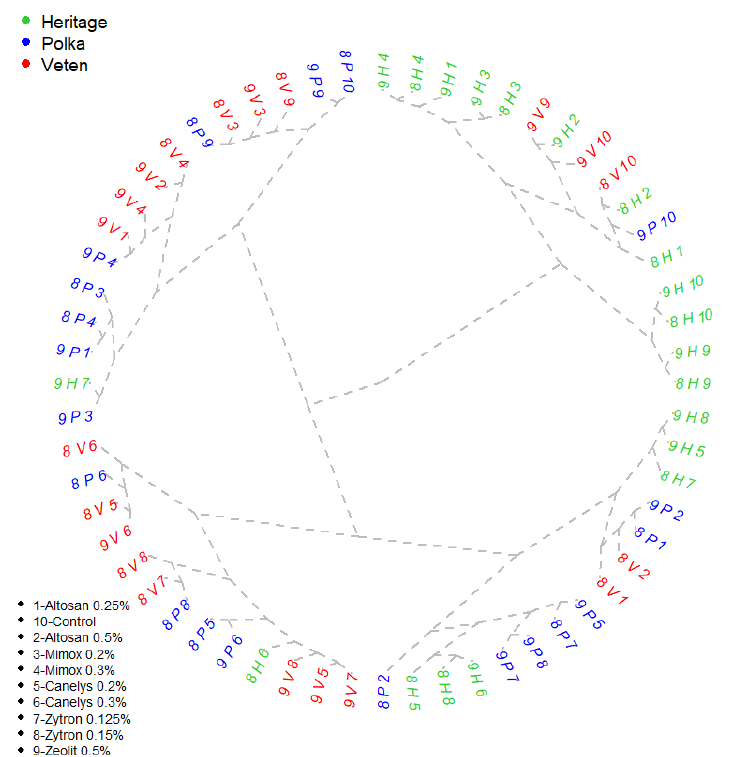
Figure 3. Cluster analysis of field treatments for organic raspberry rust disease control. First number represents the year: 8-2018; 9-2019, followed by the first letter taken from the variety’s name H- ’Heritage’; P-’Polka’; V-’Veten’. The second number represents the variant of treatment: V1-Altosan 0.25%; V2-Altosan 0.5%; V3-Mimox 0.2%; V4-Mimox 0.3%; V5-Canelys 0.2%; V6-Canelys 0.3%; V7-Zytron 0.125%; V8-Zytron 0.15%; 9-Zeolite 0.5%; V10-Control. A full description of treatment recipes is provided in Table 12.